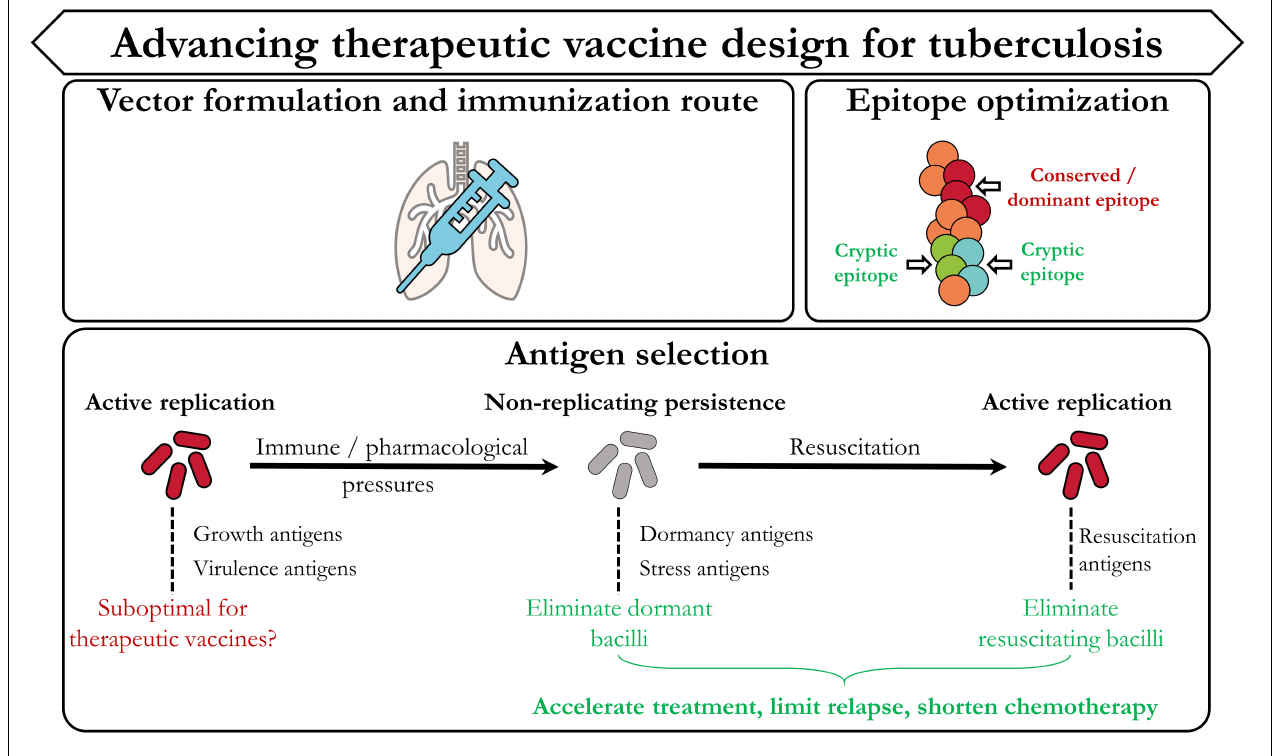
FIGURE 3 | Designing improved therapeutic TB vaccination strategies. In accordance with Figure 1 , the current TB vaccine landscape has provided invaluable evidence which can be used to improve therapeutic vaccination strategies. These include the type of vaccine vector, the route of immunization, the selection and design of the epitope(s)/antigen(s), and further focus on identifying targets from the different stages of the mycobacterial life